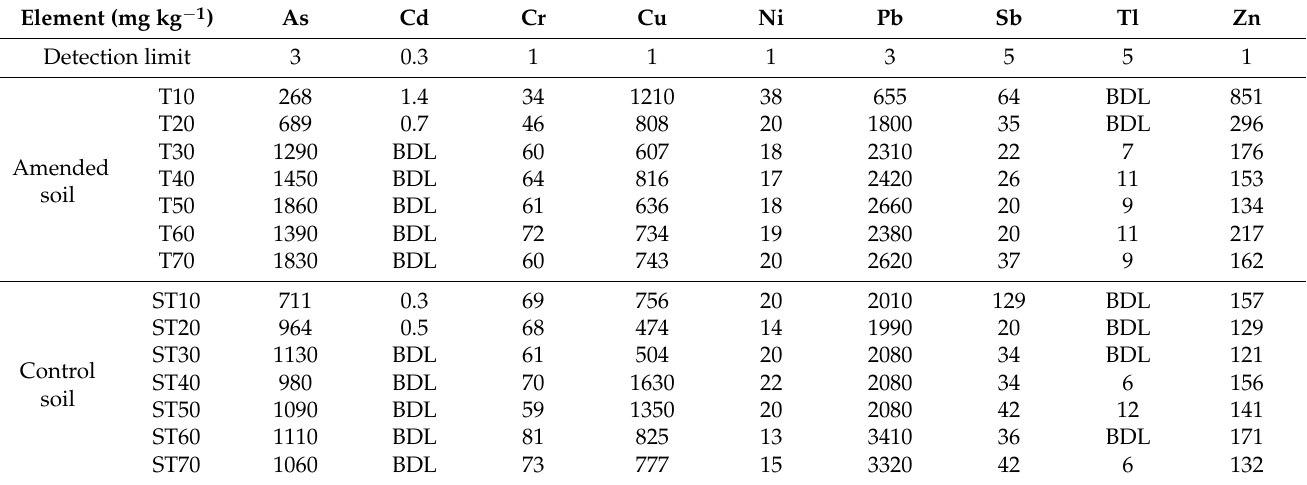
Table 2. Total trace element concentrations (in mg kg − 1 ) analyzed by